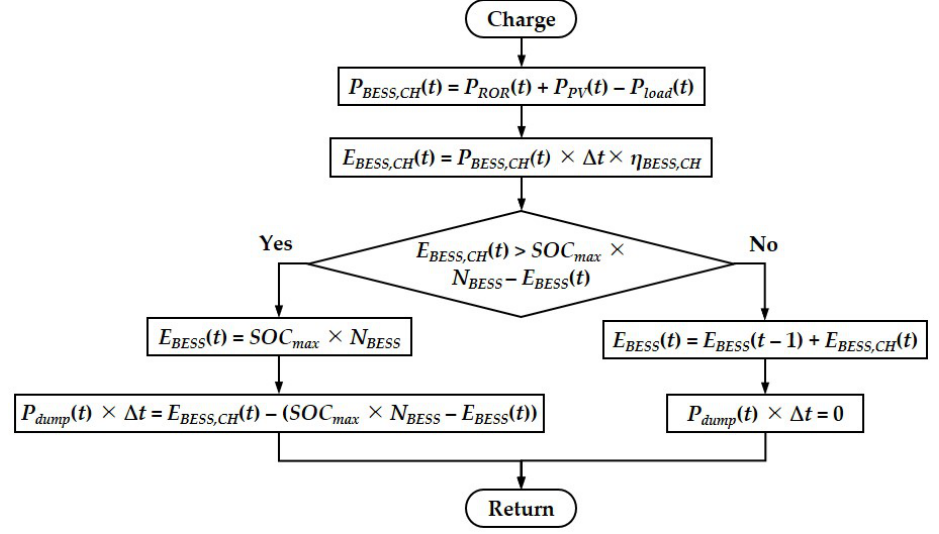
Figure 8. Flowchart of HREM charging